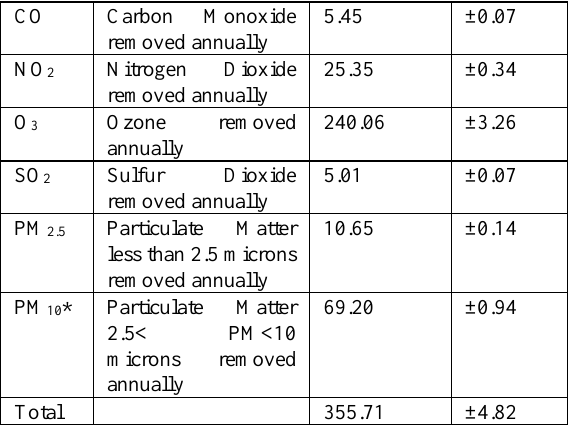
Table 4 . Contribution of Arapsuyu cemetery to ecosystem services